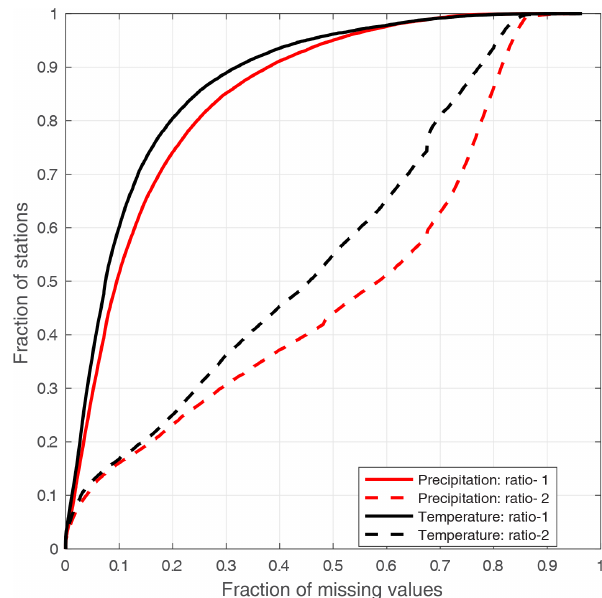
Figure 3. The fraction of missing values for stations with at least 8-year-long records. Ratio-1 is the degree of missingness during the observation period, and ratio-2 is the degree of missingness during the entire period of interest (1979 to 2018). T min is used to represent temperature because T max shows curves almost overlapping with T min